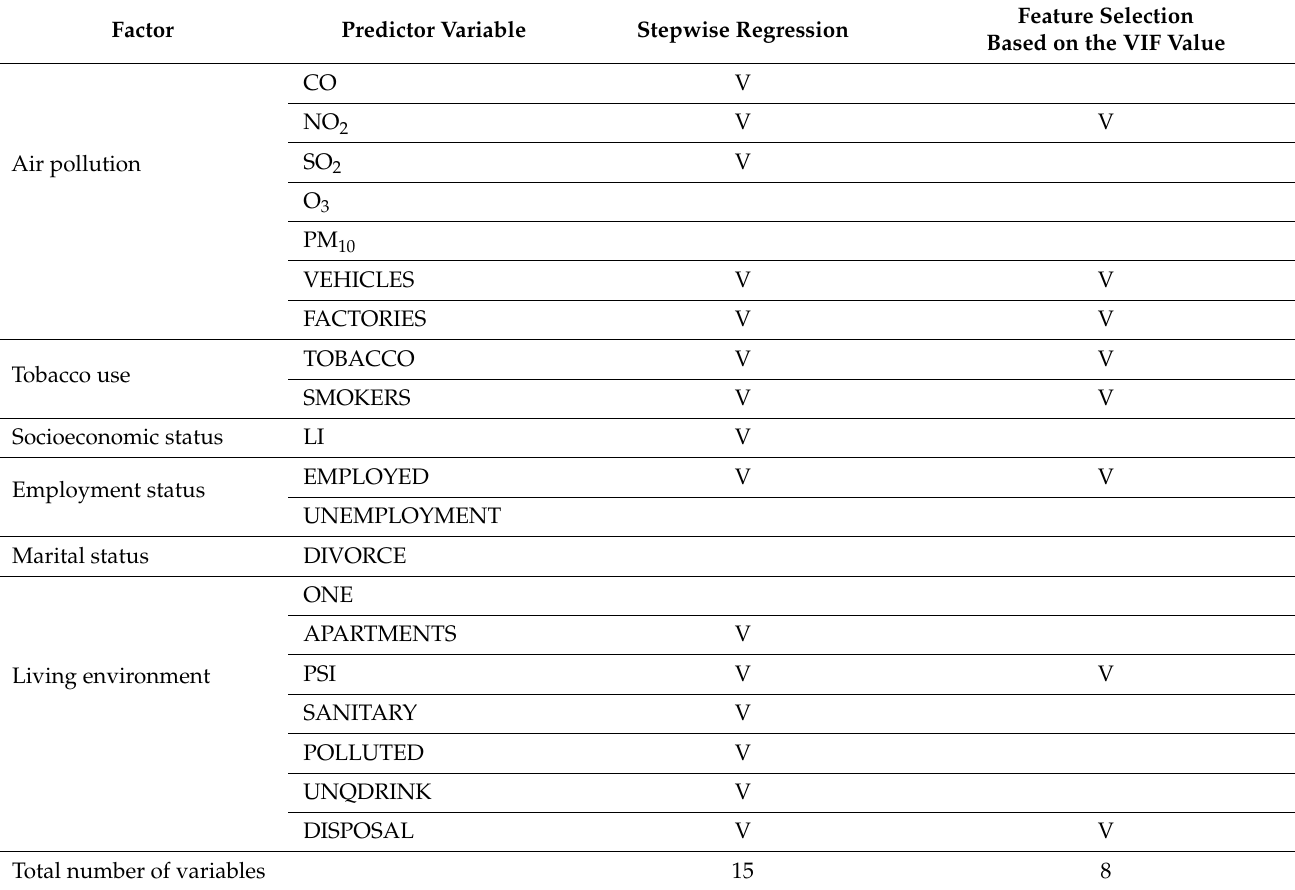
Table 2. Selected variables from the stepwise regression and feature